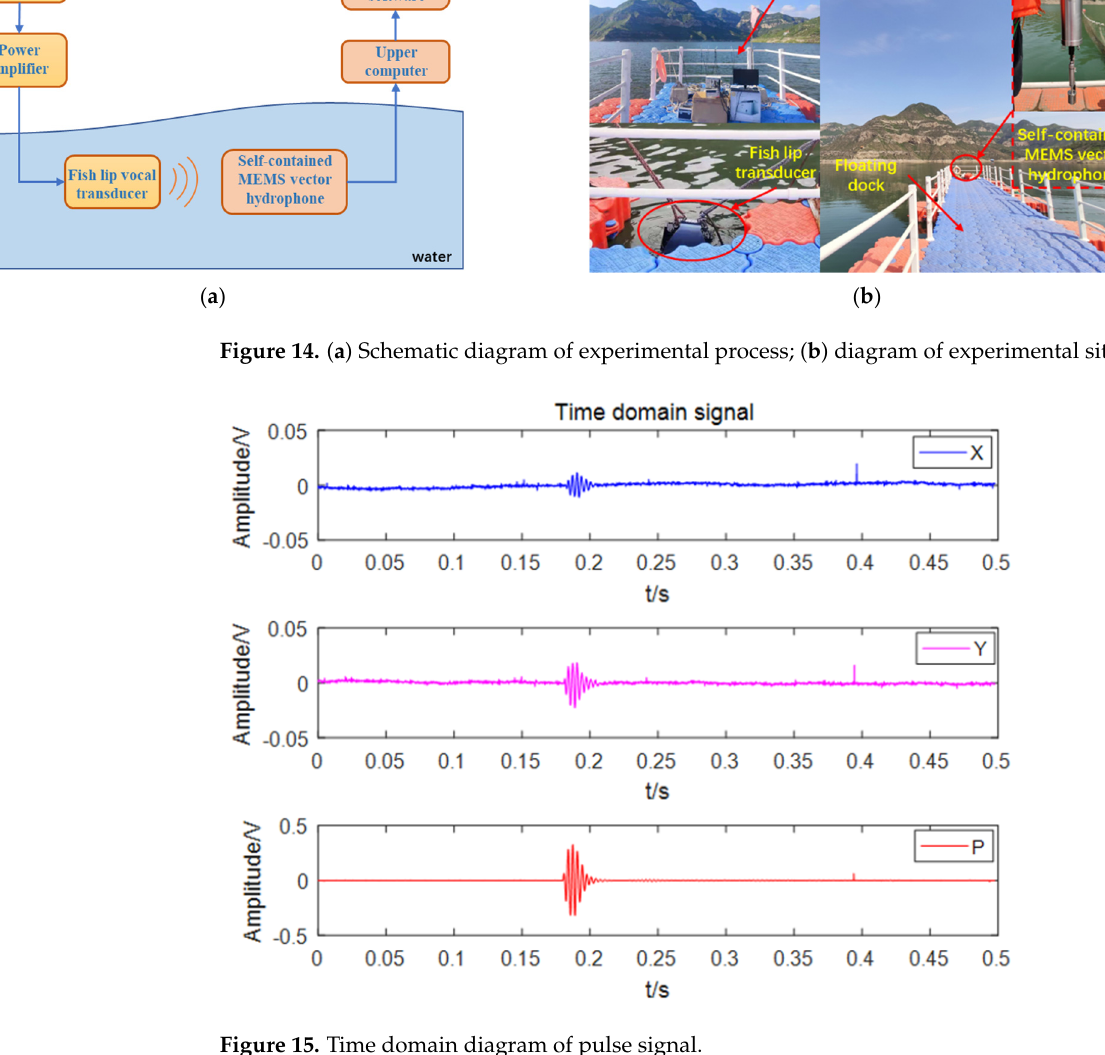
Figure 16. Direction of arrival estimation results. 4.2.2. Moving Target Experiment A mobile target test was carried out in the test water area, taking the ship as a single target sound source, and the self-contained MEMS vector hydrophone was lowered from the floating platform to a depth of 15 m underwater. The experimental site is shown in Figure 17. The ship orbited clockwise around the floating dock and used GPS to record the track information. The noise of the speedboat was collected and stored by the self- contained MEMS vector hydrophone. After the experiment, the data were read out for trajectory analysis. The ship noise power spectrum is shown in Figure 18. The power spec- tral density results show that the frequency band of broadband noise is mainly concen- trated in the low frequency range of 50–800 Hz and contains some line spectrum infor- mation. The main line spectrum characteristics are 15 Hz, 125 Hz, 140 Hz, 779 Hz and 871 Hz. The line spectrum information was used to track the motion path of the speedboat, and to select the sliding window step distance ∆𝑇 = 1 𝑠 according to the actual moving speed of the ship. The trajectory diagram drawn in MATLAB through the combined beamforming algorithm is shown in Figure 19. The duration of beamforming statistics was 50 s, and the angle of the ship changed by 20.95° relative to the hydrophone coordinates within 50 s, which is consistent with the track information recorded by GPS. The experi- mental results show that after attitude calibration and with the combined calculation anal- ysis and processing, it is possible to obtain accurate DOA information from the noise ra- diated by the ship which was collected by the self-contained MEMS vector hydrophone.